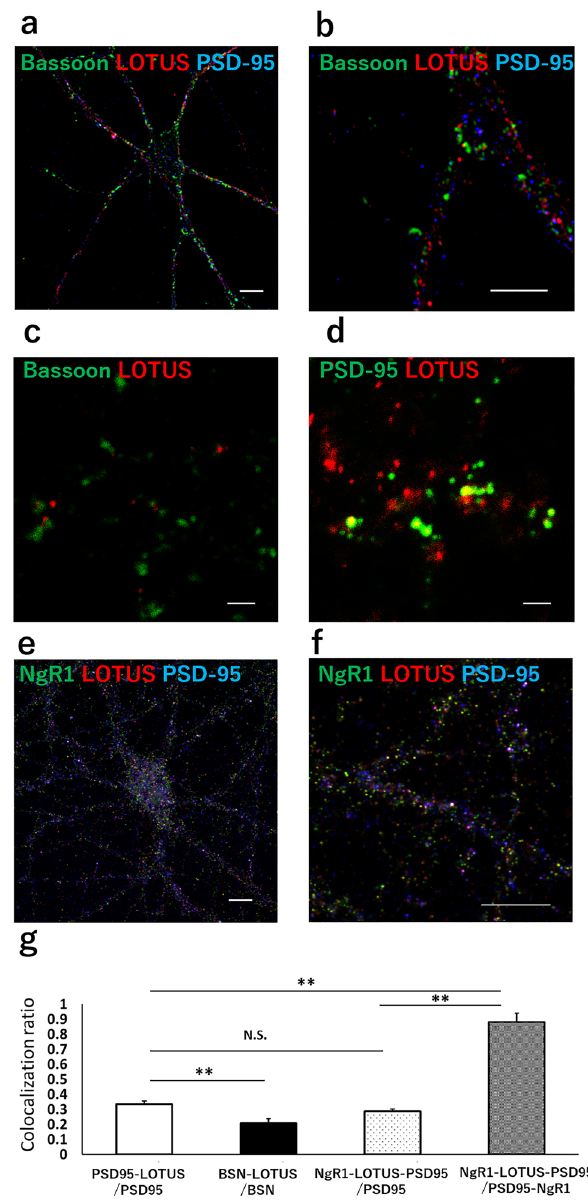
Figure 1. LOTUS is distributed in the synapse region. ( a ) LOTUS expression in cultured hippocampal neurons (DIV14). The image was acquired using a confocal microscope. PSD-95 (blue), LOTUS (red), and Bassoon (green). Scale bar, 10 µm. ( b ) Magnified image from ( a ). The segment was imaged at 5 × magnification. Scale bar, 5 µm. ( c ) Super-resolution image of Bassoon (green) and LOTUS (red) at the synapse site. The image was acquired using a STED microscope. Scale bar, 1 µm. ( d ) Super-resolution image of PSD-95 (green) and LOTUS (red) at the synapse site. The image was acquired using a STED microscope. Scale bar, 1 µm. ( e ) LOTUS and NgR1 localization in cultured hippocampal neurons (DIV14). The image was acquired using a confocal microscope. PSD-95 (blue), LOTUS (red), and NgR1 (green). Scale bar, 10 µm. ( f ) Magnified image from ( e ). The segment was imaged at 3 × magnification. Scale bar, 10 µm. ( g ) Quantification of LOTUS expression against that of Bassoon, PSD-95 and/or NgR1. Bars indicate ratio of the colocalization of PSD-95 and LOTUS in PSD-95 positive puncta (PSD95-LOTUS/PSD95), that of Bassoon and LOTUS in Bassoon positive puncta (BSN-LOTUS/BSN), that of NgR1, LOTUS and PSD-95 in PSD-95 positive puncta (NgR1-LOTUS-PSD95/ PSD95) and that of NgR1, LOTUS and PSD-95 in PSD-95 and NgR1 positive puncta (NgR1-LOTUS-PSD95/ PSD95-NgR1), respectively. Data are means ± SEM from 3–14 cells. ** P < 0.01, one-way ANOVA post-hoc